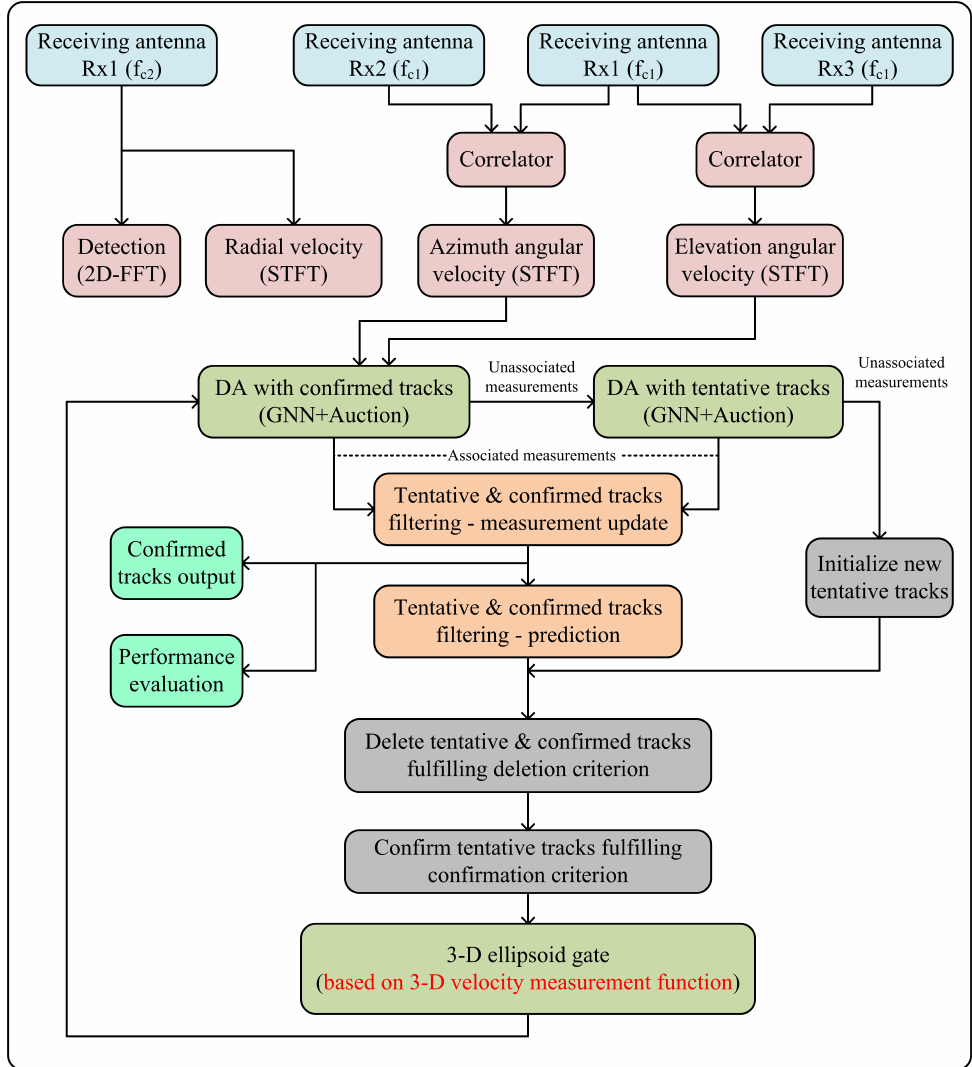
Figure 2. Illustration of the proposed MTT algorithm based on 3D velocity measurements obtained from the dual-frequency dual-orthogonal baseline interferometric